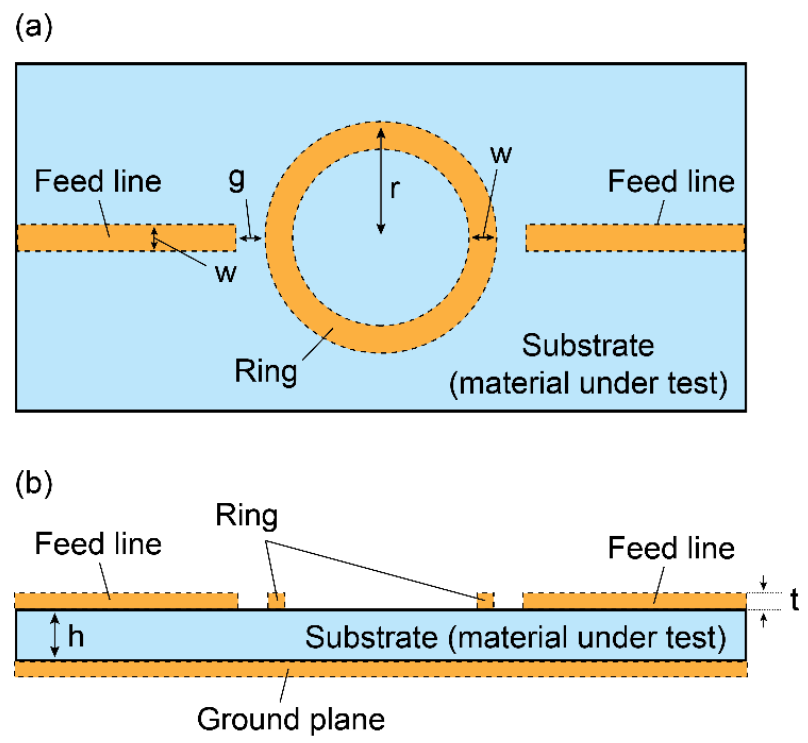
Figure 11. Schematic illustration of a ring resonator embedded with a material under test for dielectric characterization in ( a ) top and ( b ) cross-sectional views. Redrawn from [94] (p. 15). Although the ring resonator method could offer a good estimation of the complex The loss tangent ( tan ) of the test sample can be obtained by [95]: relative permittivity in the microwave frequency domain, a preparatory phase is required to embed a testing material into the ring resonator geometry, but such process could be laborious and for certain samples even impracticable [94]. In order to ease the challenges in the sample preparation, multilayer methods such as the suspended ring resonator method and the strip line ring resonator method were proposed. layer [94,96] (Figure 12). The lower layer consists of a ground plane and two feed lines mounted onto a dielectric medium of known complex permittivity, and the upper layer consist of the same dielectric material but this time with a ring. These lower and upper layers can be fabricated based on the conventional, printed circuit board technology. The sample is then placed in-between, and its complex relative permittivity can be determined through the measurements of the resonant frequency and quality factor in a similar manner to the original, ring resonator method. The specific formulas for the suspended ring resonator method are available in